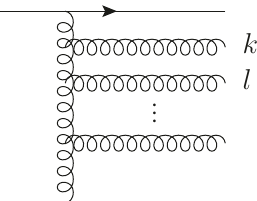
Figure 2 . Strong rapidity ordering in successive gluon